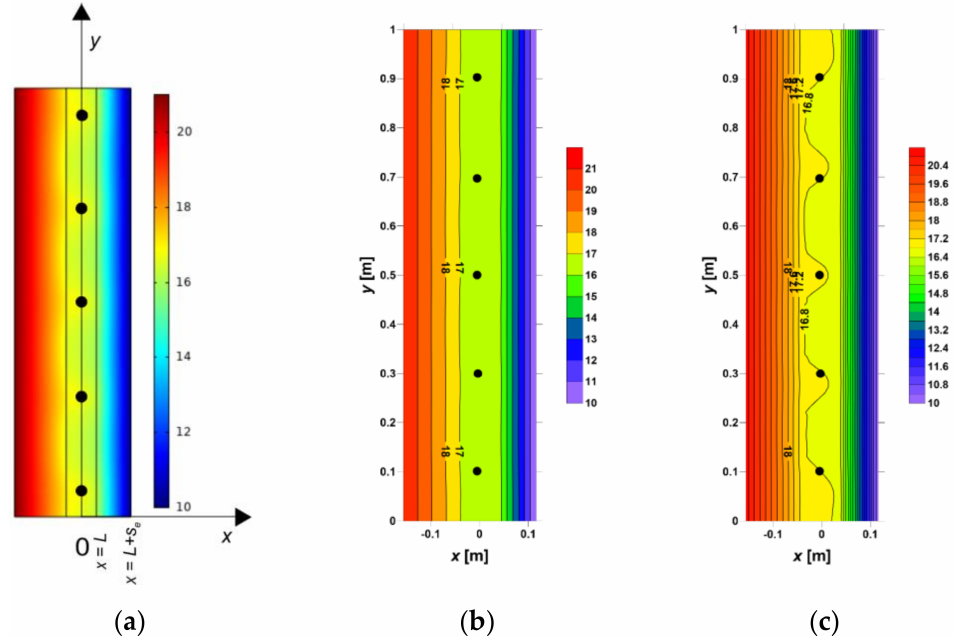
Figure 5. ( a – c )Temperature maps in a three-layer envelope with heat supplied to the middle layer for a different density of isolines.